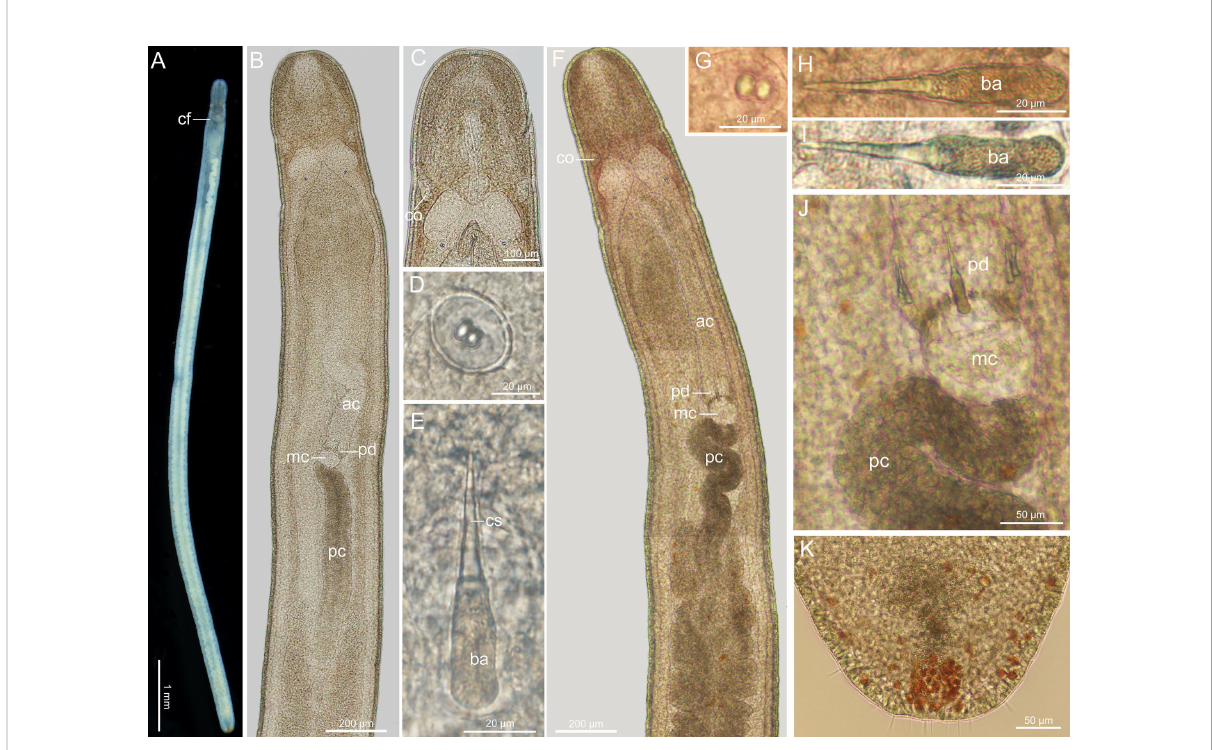
FIGURE 4 Ototyphlonemertes ( Ototyphlonemertes ) chernyshevi [Ca1] (A – E) and Ototyphlonemertes ( Ototyphlonemertes ) chernyshevi [Ca2] (F – K) . (A) Photograph of a live specimen; (B, F) composite photomicrographs of squeezed specimens; (C) photomicrograph of anterior region of a squeezed specimen; (D, G) statoliths; (E, H, I) central stylet and basis; (J) photomicrograph of partial proboscis from a squeezed specimen; (K) posterior end of body. ac, anterior chamber of proboscis; ba, basis; cf, cephalic furrow; co, cerebral organ; cs, central stylet; mc, middle chamber of proboscis; pc, posterior chamber of proboscis; pd, proboscis